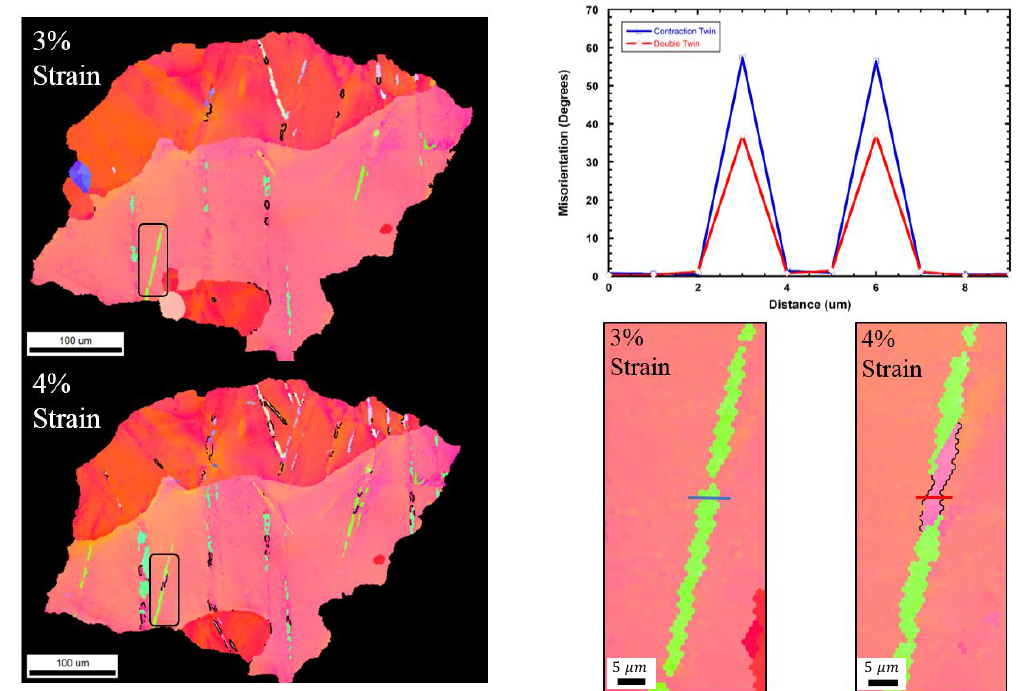
Figure 19. Characterization of double twinning at low stresses. The twin of interest is fully formed by 3% strain and does not show signs of double twinning. By 4% strain, the twin of interest begins to double twin at the middle. Misorientation analysis between the double twin and the contraction twin is compared to confirm the presence of contraction and double